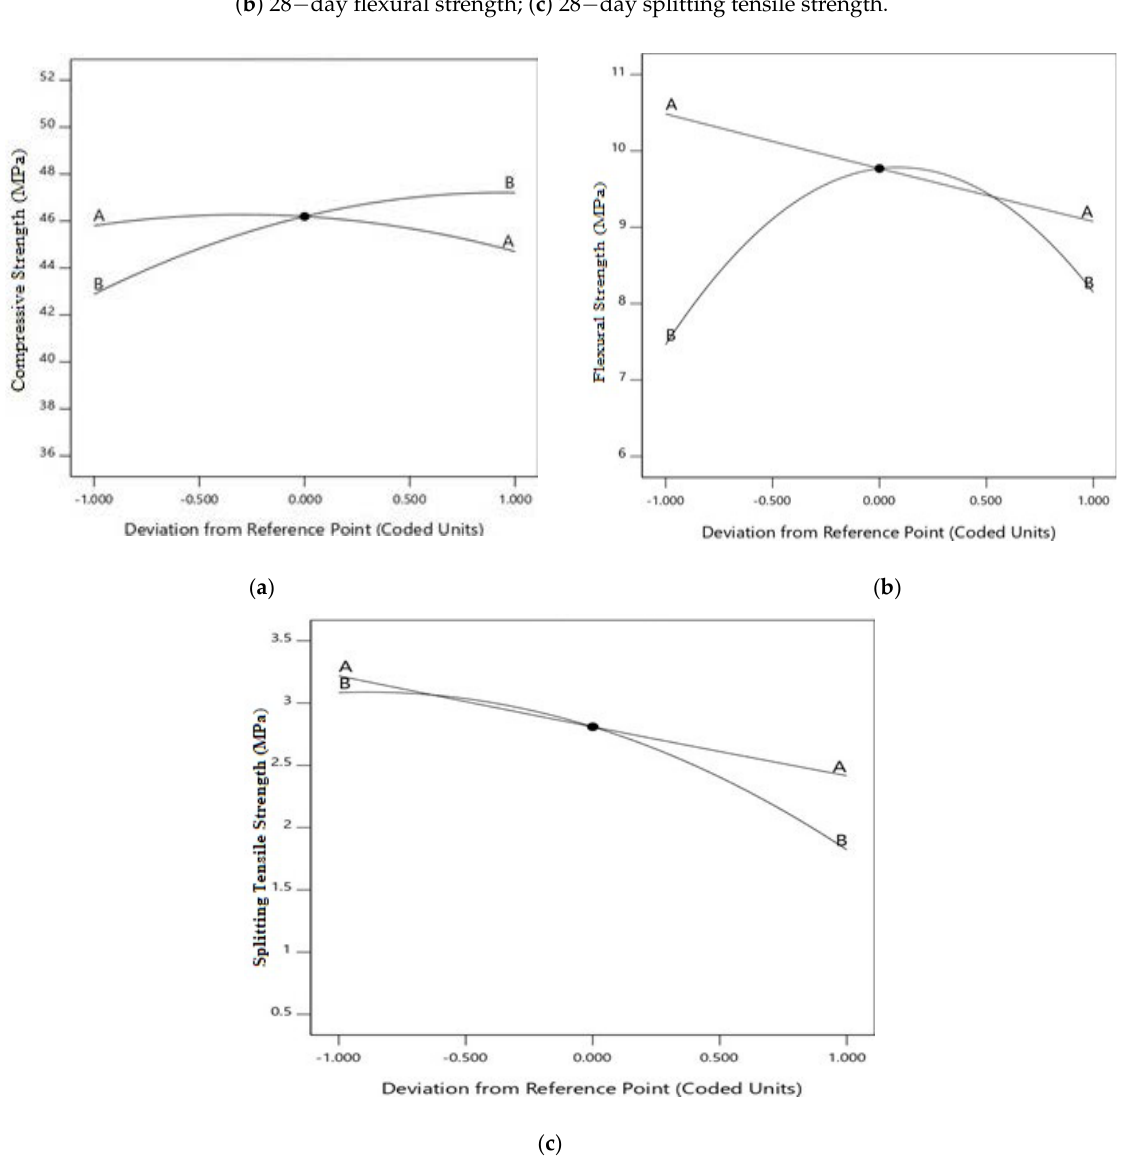
Figure 9. Perturbation plots: ( a ) 28 − day compressive strength; ( b ) 28 − day flexural strength; ( c ) 28 − day splitting tensile strength.